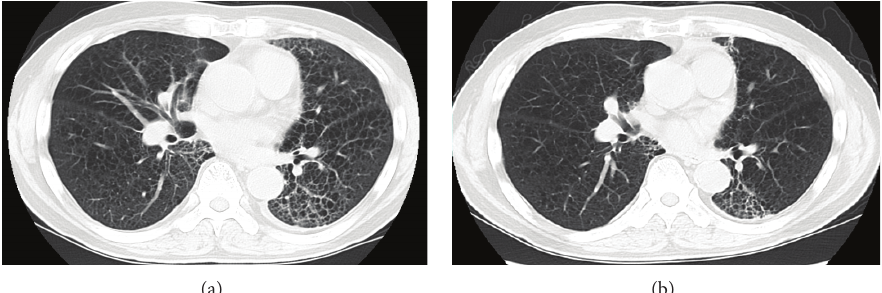
Figure 1: Chest CT scan on admission (a) shows bilateral ground-glass and reticular opacities. Fifteen days after the administration of corticosteroid, bilateral ground-glass opacities reduced (b).